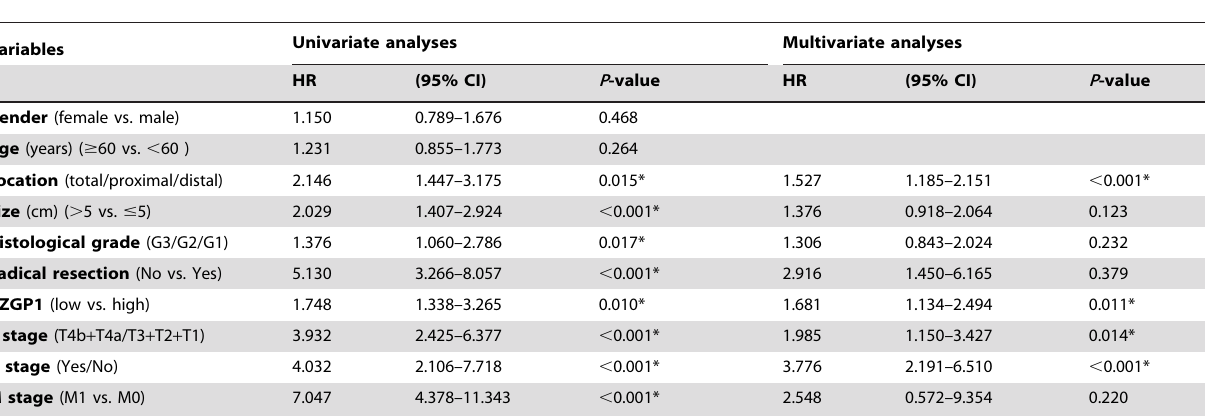
Table 2. Univariate and multivariate survival analysis of clinic-pathologic variables in 248 cases of gastric carcinoma patients.